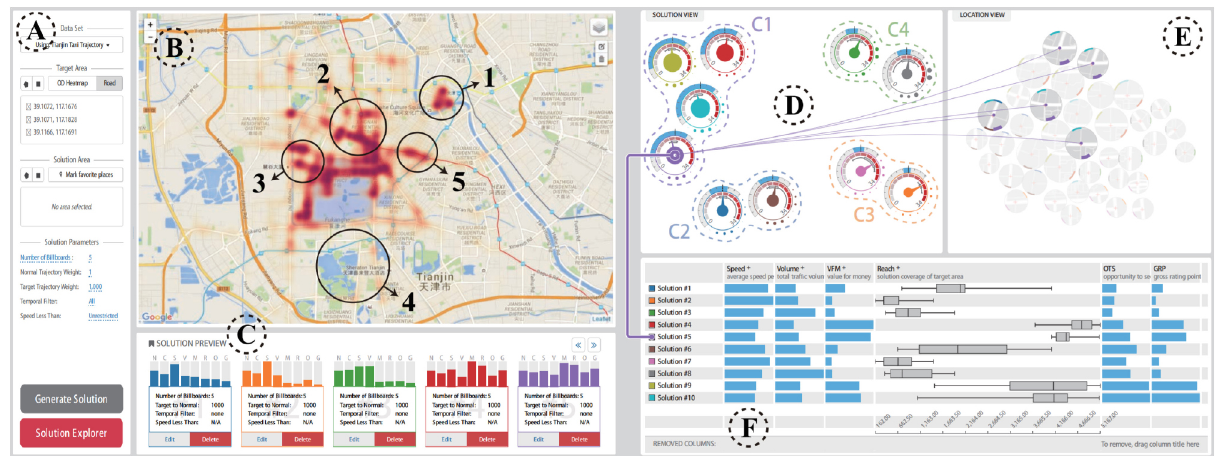
Fig. 9 Interface of SmartAdP, a visual analytics system for selecting billboard locations based on taxi trajectories. Reproduced with permission from Ref. [98], c (cid:13) IEEE 2017.